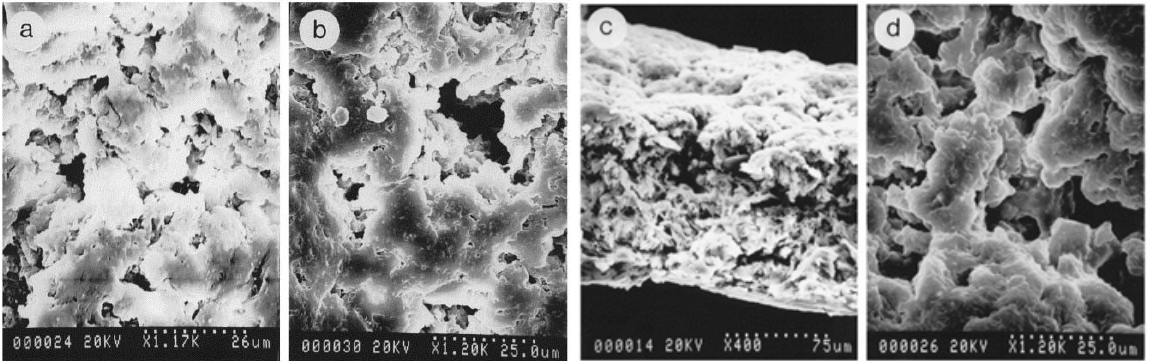
Figure 17. Scanning electron micrographs of the PLGA/F127 (90:10, w / w ) matrices after 1-day ( a : surface), 6-day ( b : surface; c : cross section) and 18-day ( d ) incubations in buffer. These show the interconnected open pore structure and also that they extend to the surface without a decrease in size that would make them less accessible. Reproduced from [61] with permission from